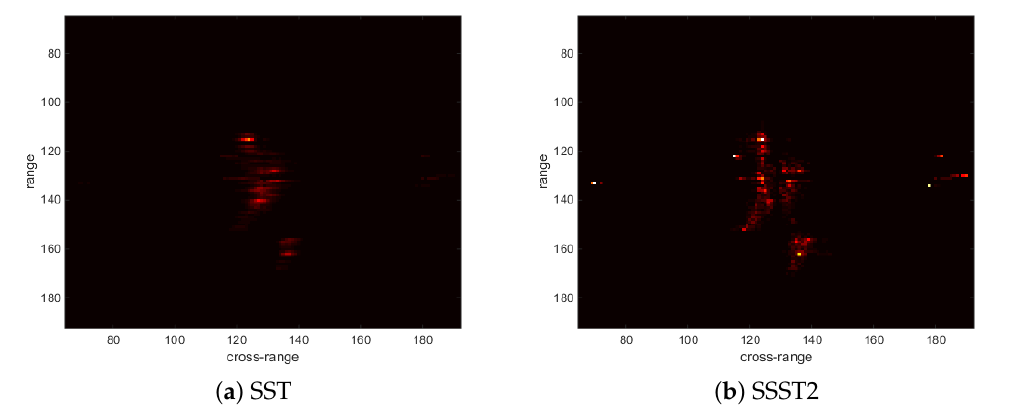
Figure 10. Time-frequency and imaging analysis results of real An-26 data.